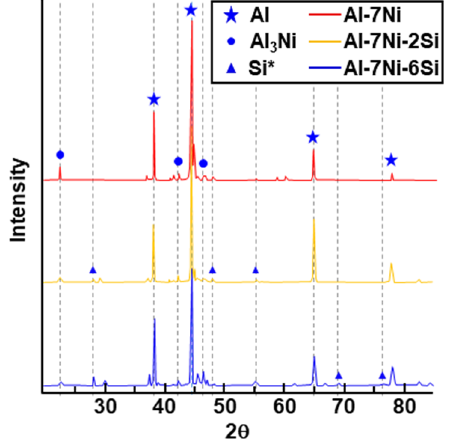
Figure 3. XRD analysis result of coating that was hot ‐ dipped at 690 °C for 120 s, depending on amount of Si added based on Al–7Ni wt % composition. Si*: Si(Fd ‐ 3m).